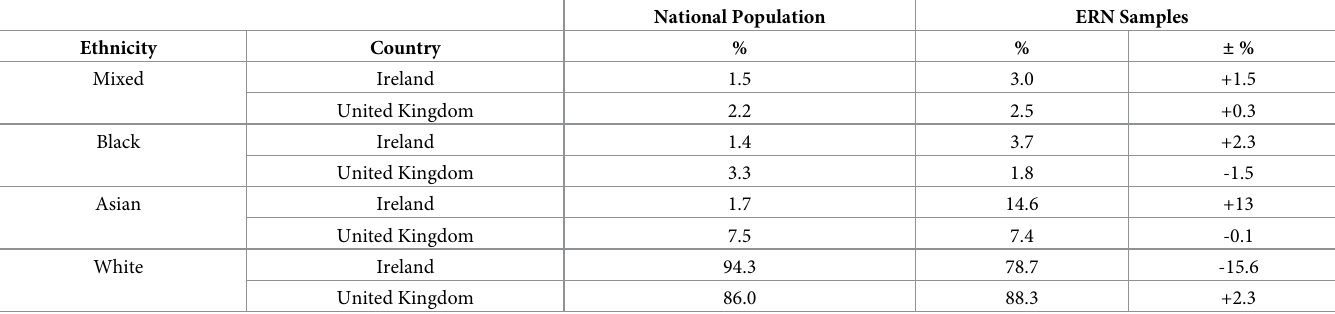
Table 6. Comparison of ethnicity of national population and participating science festival visitors.